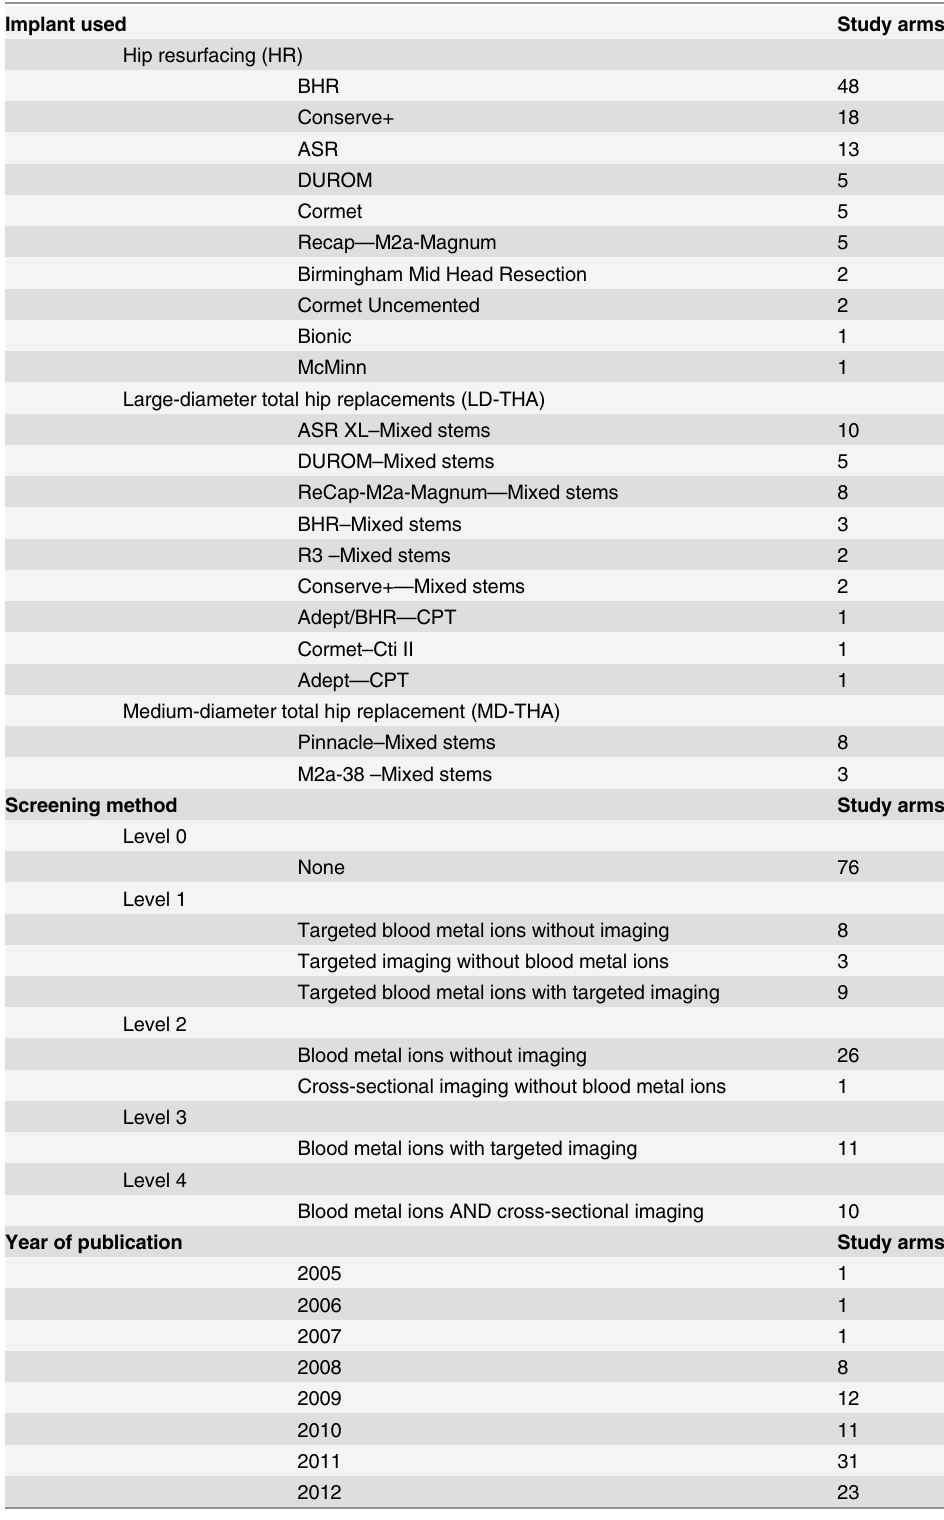
Table 2. Summary data of the study